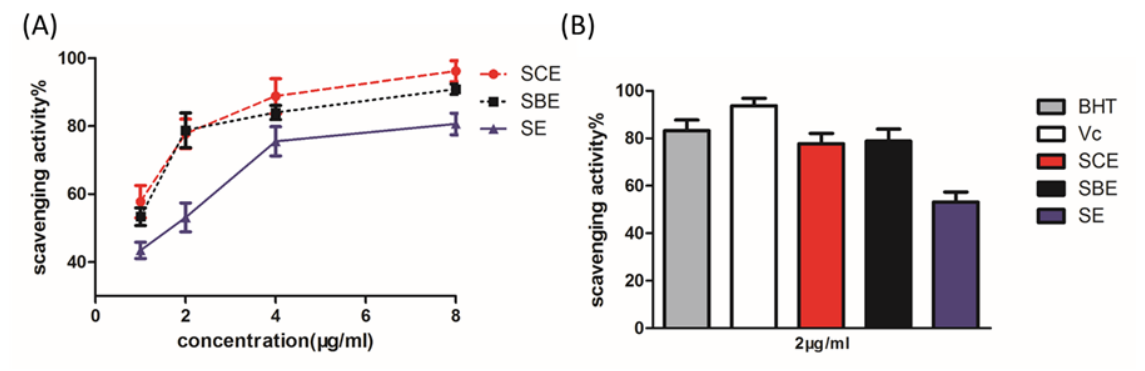
Figure 1: DPPH radical scavenging activities of (A) CEOs and (B) compared with Vc and BHT at the concentration of 2μg/mL. Each value is expressed as mean ± SEM.